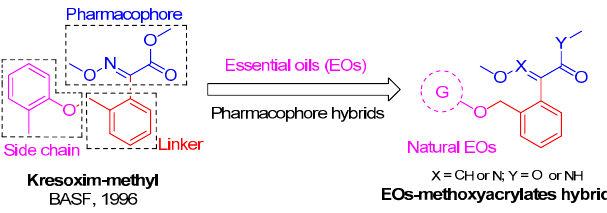
Figure 2. Design strategy of EOs-based β -methoxyacrylate derivatives.